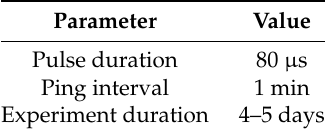
Table 5. Echosounder parameters used during data collection of long-term